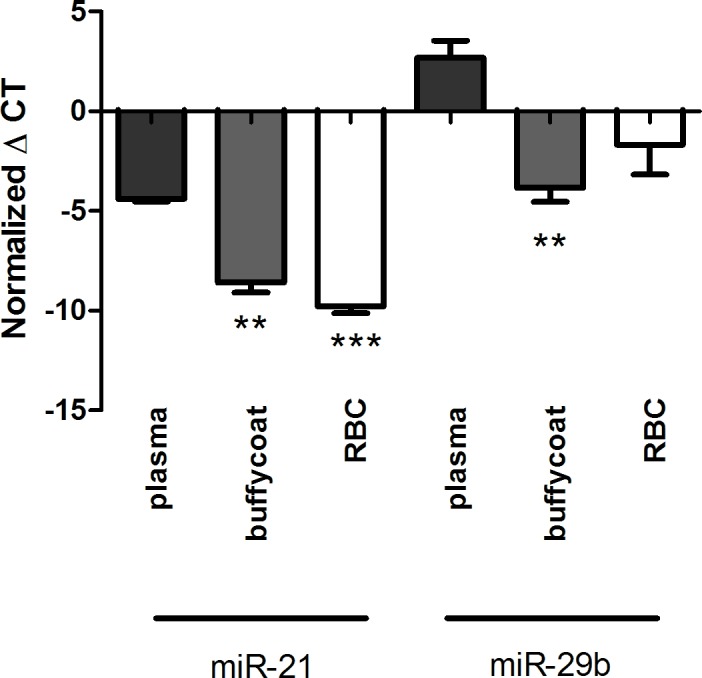
MiRNA levels in the 3 blood fractions; plasma, buffy coat and red blood cells (RBC).The two miRNAs, miR-21 and miR-29b, were differently distributed in the fractions; there are significant higher levels of miR-21 in the buffy coat and RBC compared to plasma, and miR-29b plasma levels are significantly lower than in the buffy coat. Statistically significant differences in miRNA expression are marked with asterisks (*).**p<0.01, ***p<0.001.